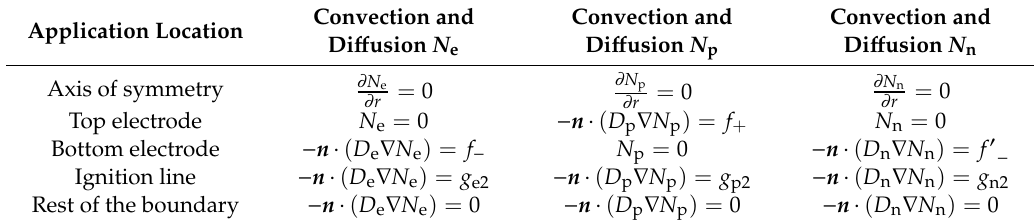
Table 2. Boundary conditions.